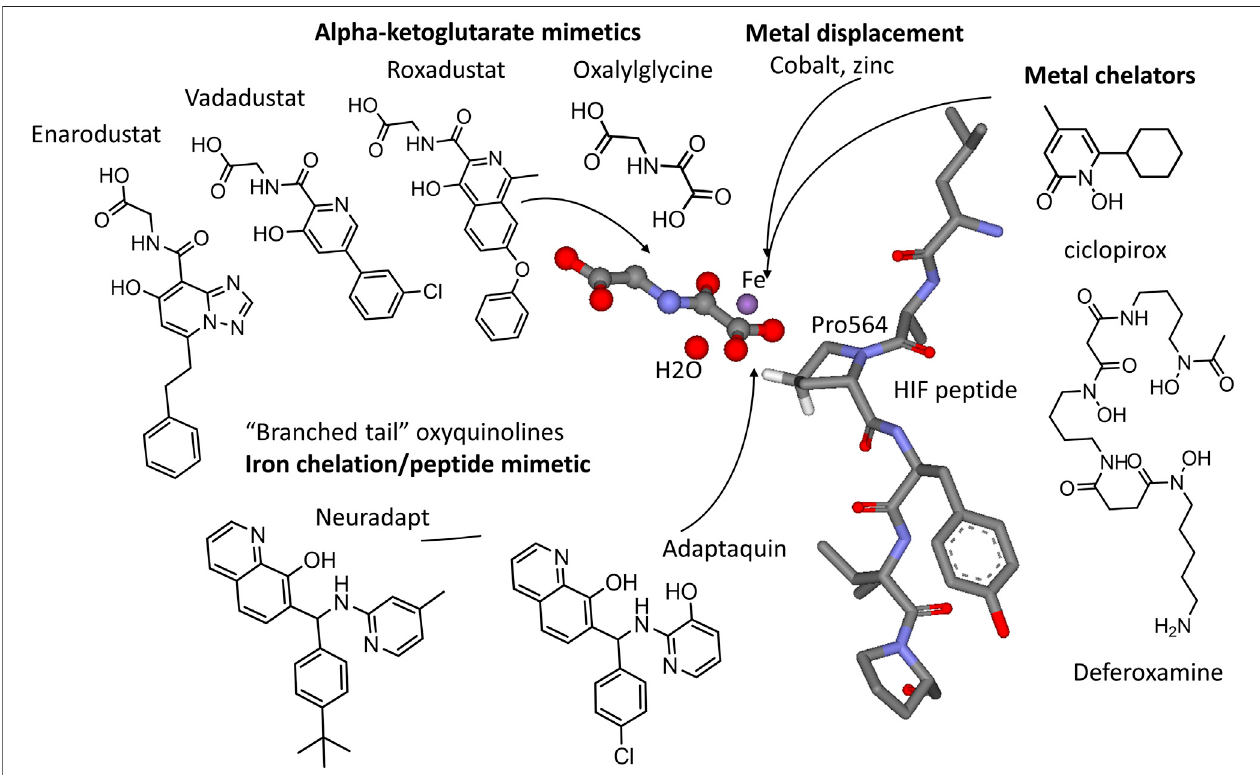
FIGURE 2 | HIF PHD inhibitors and their targets in the active site of HIF prolyl hydroxylase (3HQR.pdb). Alpha-ketoglutarate mimetics include N-oxalylglycine (DMOG), Roxadustat, Vadadustat, and Enarodustat. Metal chelators, e.g., ciclopirox, deferoxamine (DFO), and various transition metals target the active site iron (in purple). Branched tail oxyquinolines (adaptaquin and neuradapt) provide two ligands to chelate iron and to mimic the fold of the HIF peptide.